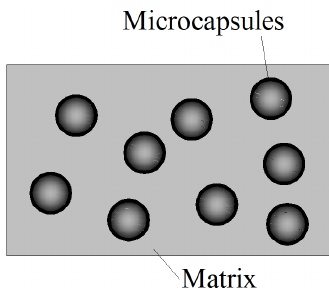
Figure 1. Schematic illustration of microcapsule-contained cementitious composites.